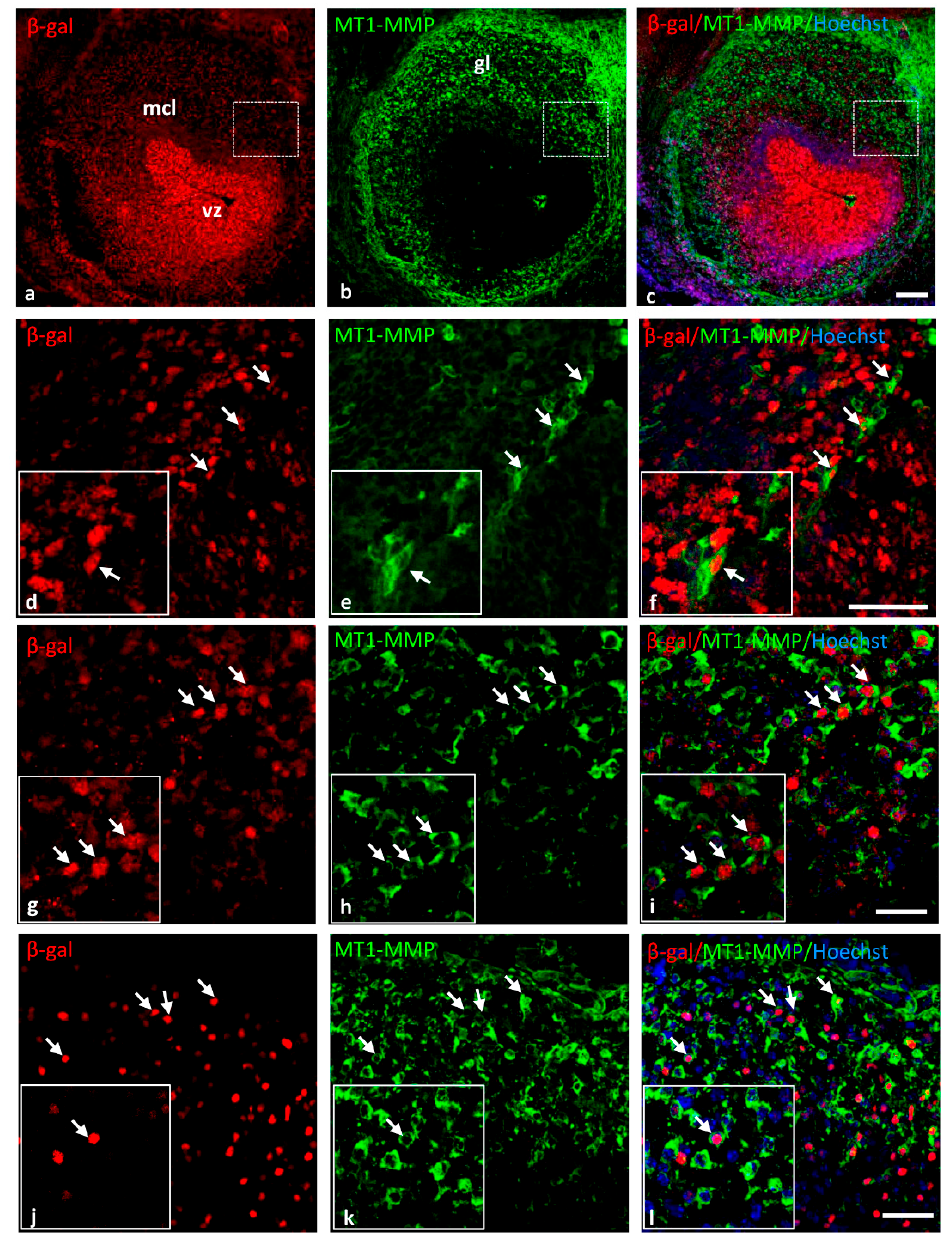
Figure 6. MT1-MMP is expressed in the olfactory bulb, the cerebral cortex and the superior colliculus of E14.5 HT embryos. Double-labeling immunohistochemistry for β -gal (in red) and MT1-MMP (in green) confirmed the expression of the enzyme and the reporter β -gal (white arrows) in the olfactory bulb ( a – f ), the cerebral cortex ( g – i ) and the superior colliculus ( j – l ). Abbreviations: gl: glomerular layer; mcl: mitral cell layer; vz: ventricular zone. Scale bars: 100 µm ( a – c ) and 50 µm ( d – l ).